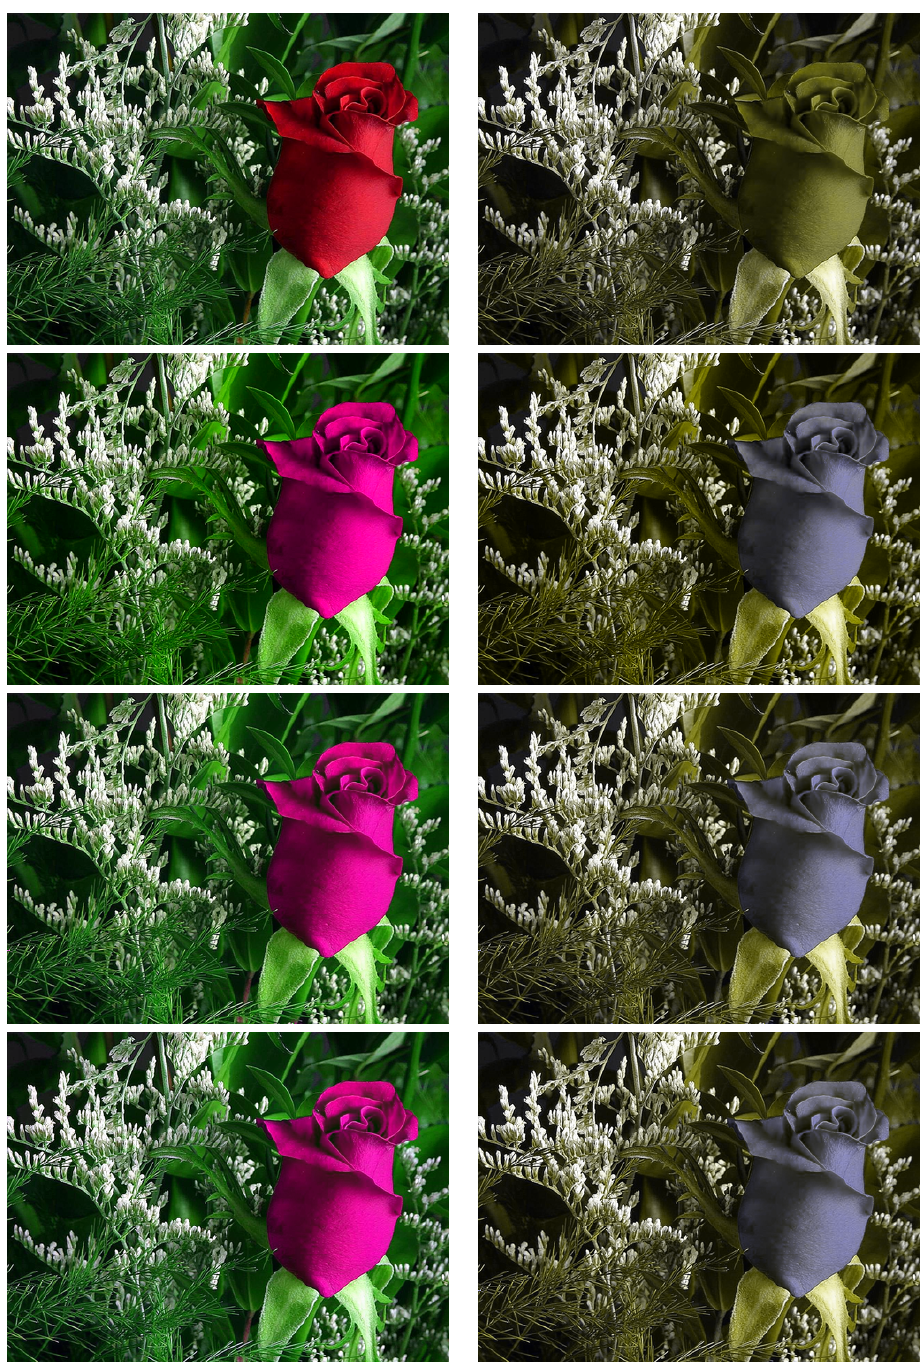
Figure 5. Example of colour image Daltonisation by the proposed method. Colour images in the left column, and corresponding colour–vision–deficiency simulations in the right. Top to bottom: original image, simple global Daltonisation, ad hoc anisotropic gradient domain Daltonisation, and the proposed variational gradient-domain